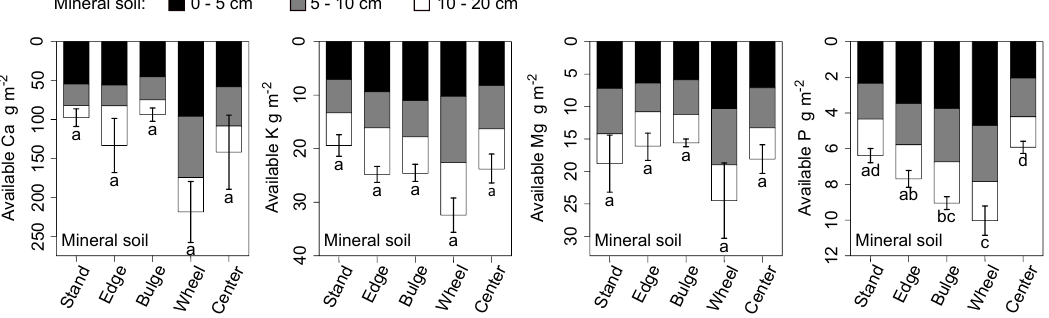
Figure 3. Available mineral soil nutrient stocks by depth and stratum in 2015 (exchangeable cations with NH Cl and citric acid-extractable P). Letters indicate significant differences in complete stocks 4 between strata (Dunn’s test, p < 0.05). Bars are one standard error of mean, complete